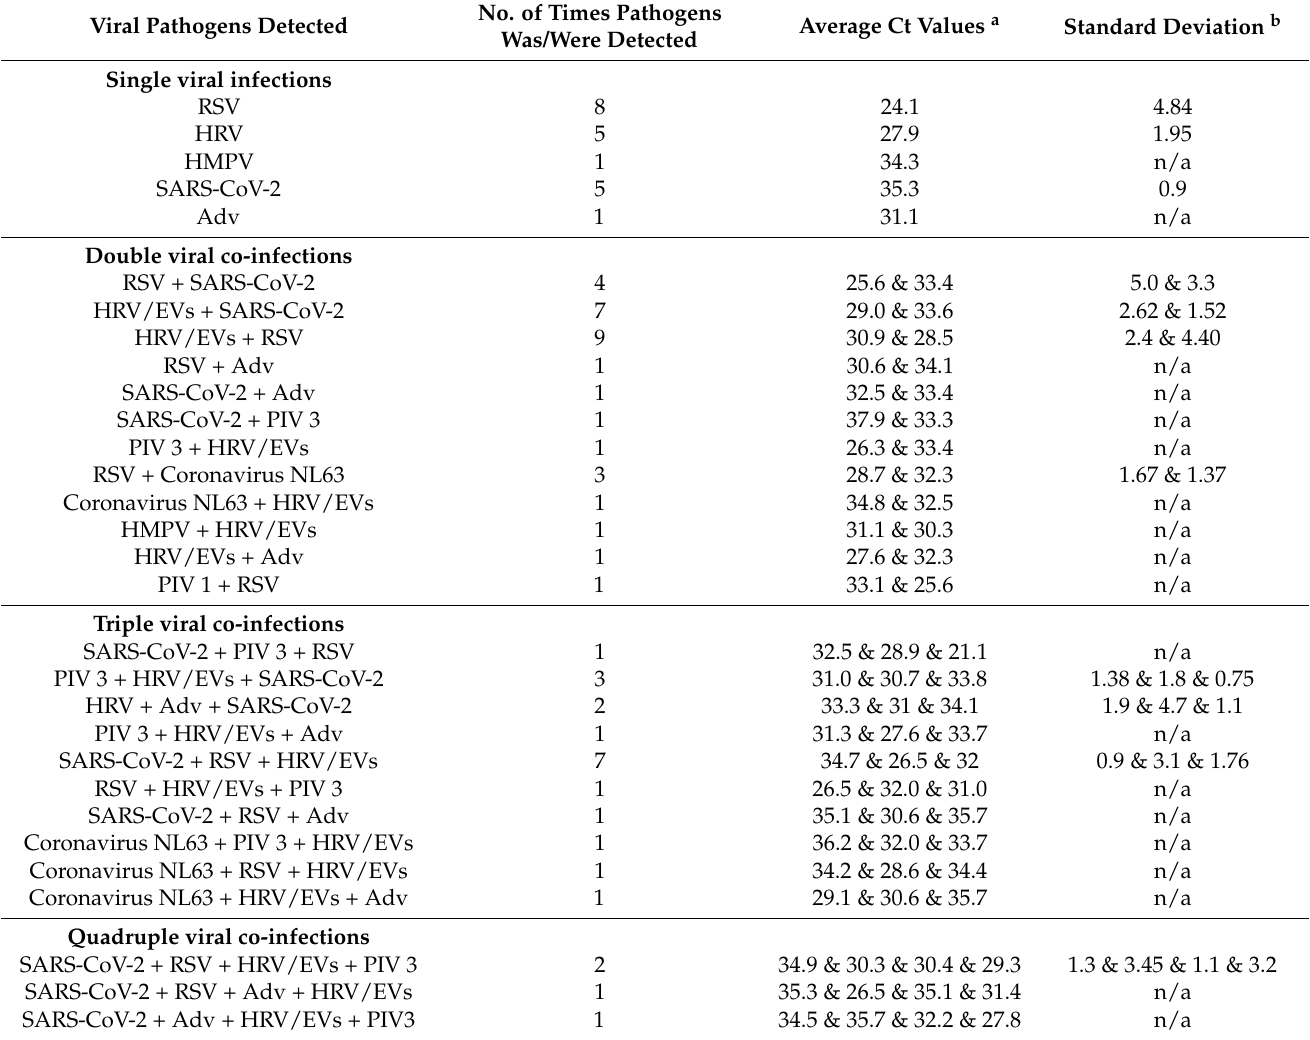
Table 2. Pathogens detected in single and co-infections and detected Ct